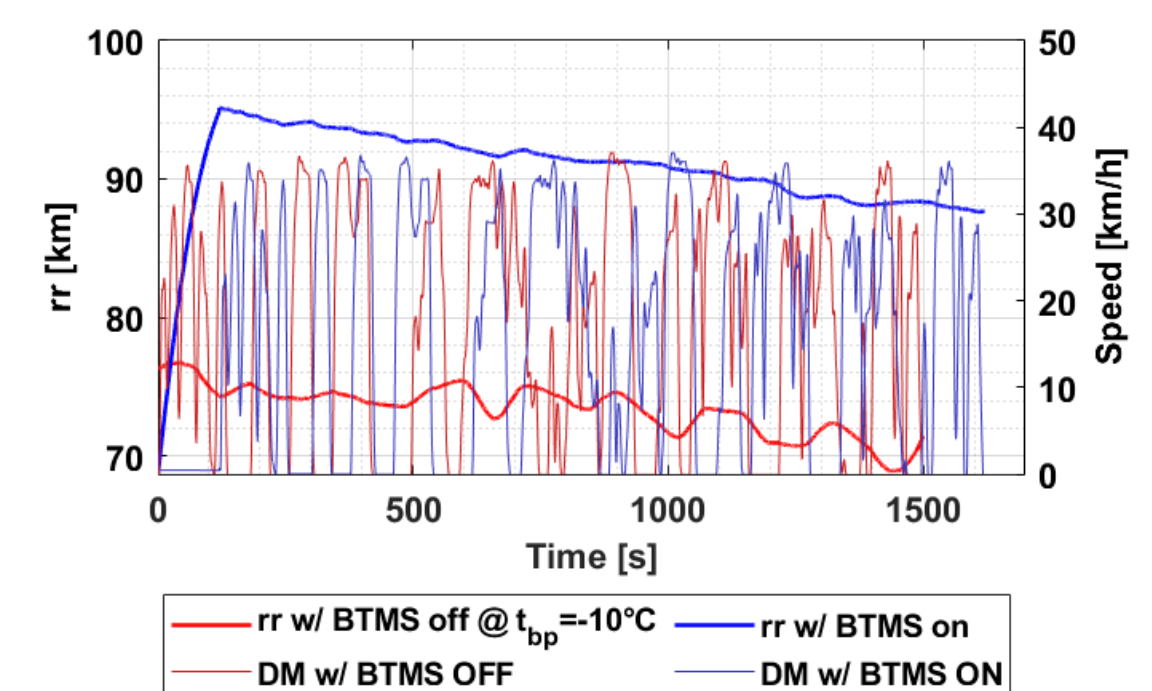
Figure 35. Comparison of residual driving range estimated with (blue curve) and without (red curve) thermal management of the BTMS for DM09 for an initial battery pack temperature of -10 °C.